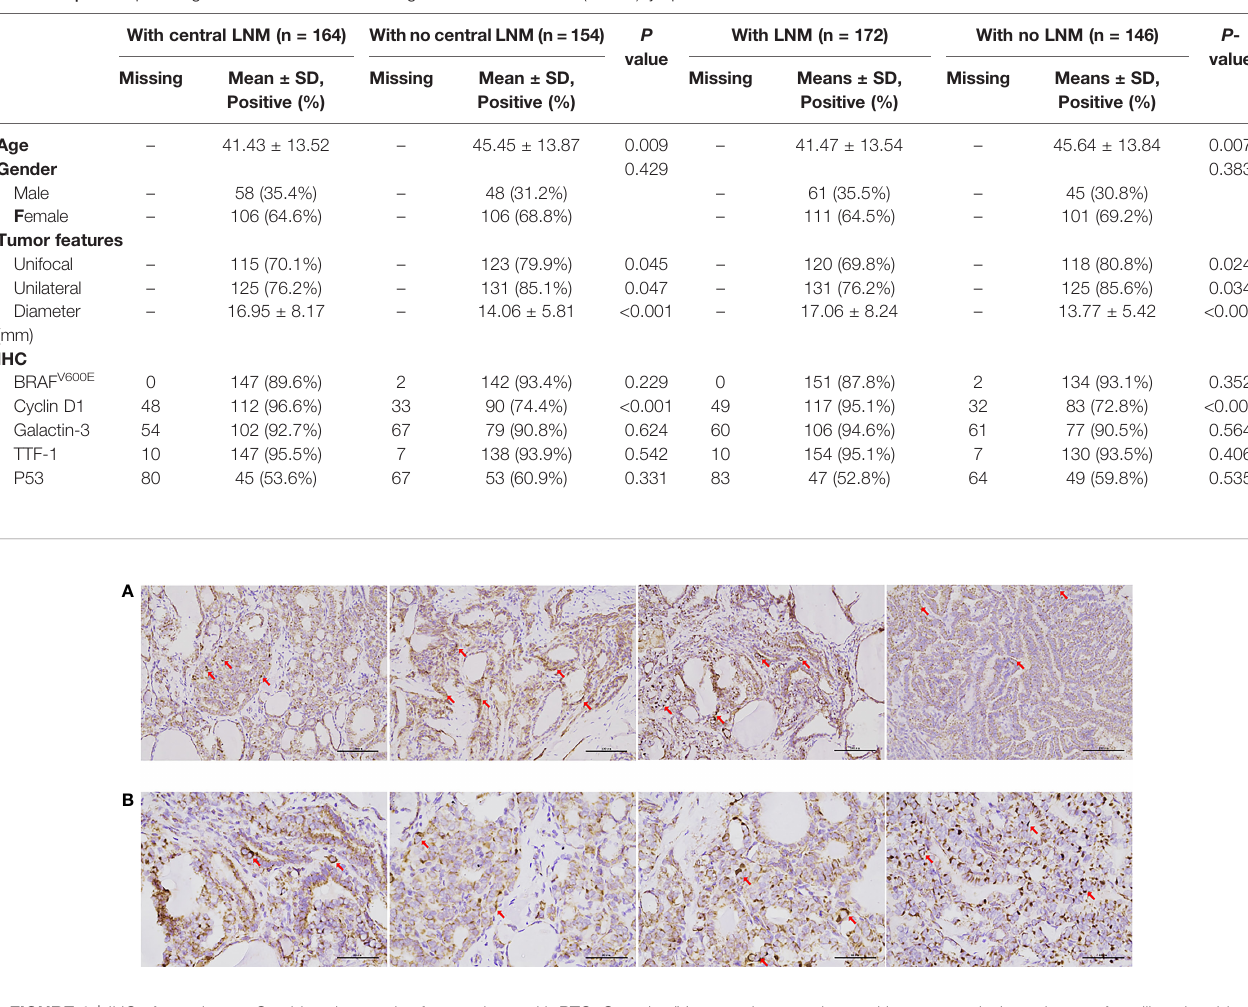
FIGURE 1 | IHC of cytochrome C oxidase in samples from patients with PTC. Complex IV expression was detected in most surgical specimens of papillary thyroid carcinoma with central or lateral lymph node metastasis. (A) Immunohistochemistry, 20× (scale bar: 100 m m). (B) IHC, ×40 (scale bar: 50 m m). Cells and areas indicated by red arrows are highly pigmented, indicating high levels of cytochrome c oxidase expression.